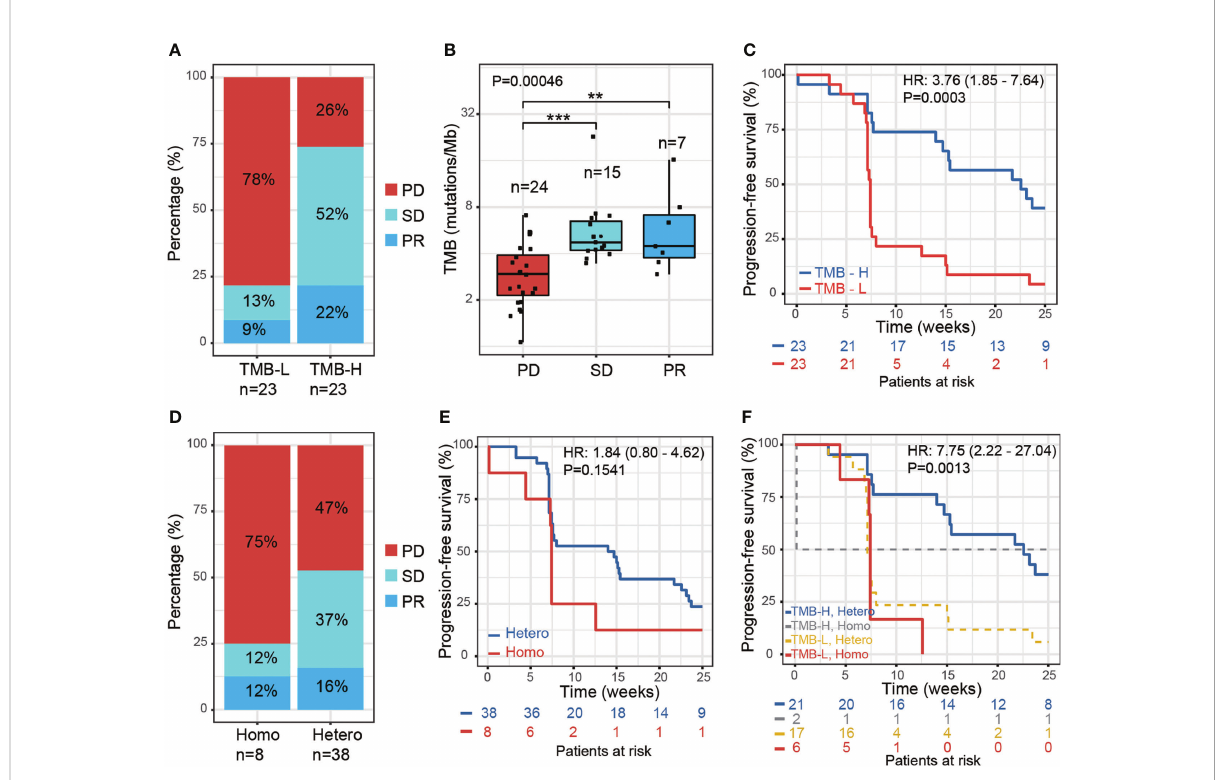
FIGURE 1 Effect of tumor mutation burden and HLA-I heterozygosity on survival after anti-PD-1 treatment. (A) The percentage of PR, SD and PD in patients with low TMB (TMB-L, TMB < 4, n=23) and high TMB (TMB-H, TMB > 4, n=23). (B) A boxplot of tumor mutation burden for PD (n=24), SD (n=15) and PR (n=7) patients, P values were calculated using the Kruskal-Wallis test. Asterisks denote pairwise group comparisons by Dunn ’ s test (** P <0.01; *** P <0.001). (C) Progression-free survival analysis of patients with high and low tumor mutation burden. (D) The percentage of PR, SD and PD in the patients with homozygosity in at least one HLA-I locus (Homo, n=8) and with heterozygosity at all HLA-I loci (Hetero, n=38). (E) Progression-free survival analysis of patients with homozygosity compared with heterozygosity in the HLA-I allele. (F) Progression- free survival analysis of patients with high tumor mutation burden and heterozygosity at all HLA-I loci (TMB-H, Hetero, n=21) compared with patients that have low tumor mutation burden and are homozygous for at least one HLA-I locus (TMB-L, Homo,